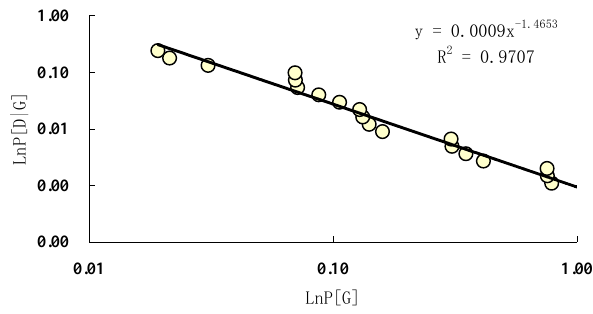
Fig. 9 Relationship between posterior probability P[D|G] and the probability of the area (G) with cutoff value of posterior probability. Fig. 9. Relationship between posterior probability probability of the area (G) with cutoff value of posterior